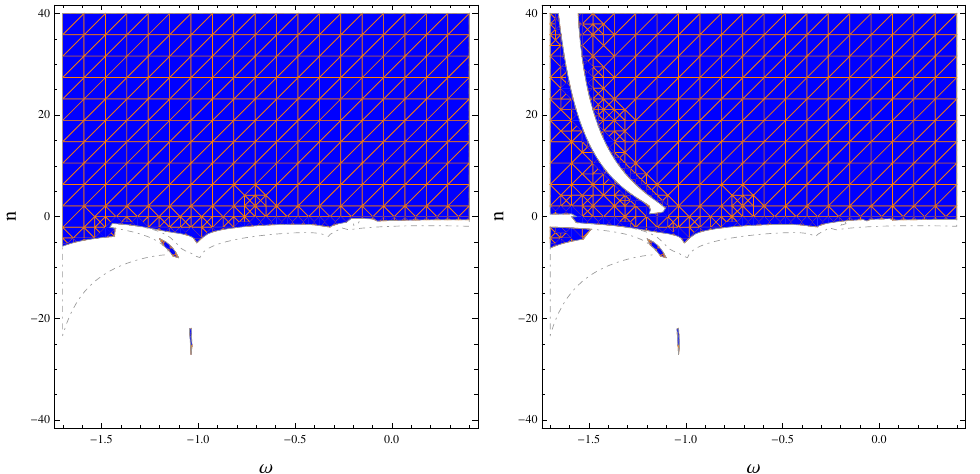
Figure 4. Stable regions of the ESU for K = 1, λ 2 = 2 (blue) and λ 2 = 15 (orange), corresponding to η = 1 ( left ) and η = − 1 ( right ).